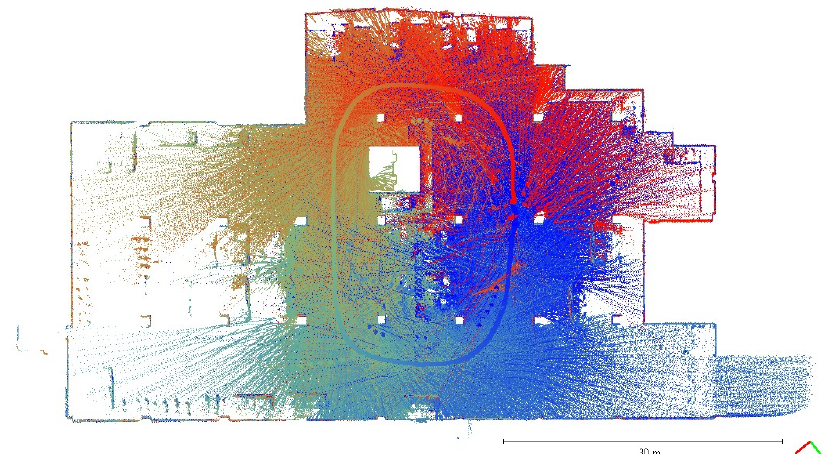
Figure 8. Point cloud colored by scanning time and the scanning trajectory of dataset DATA1.